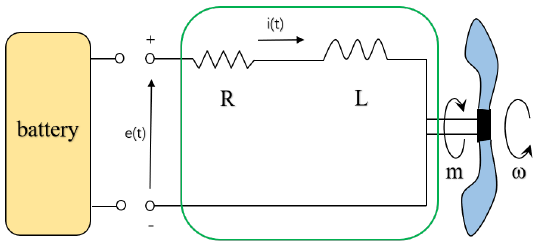
Figure 1. The BLDC electrical motor model for a rotary − wing